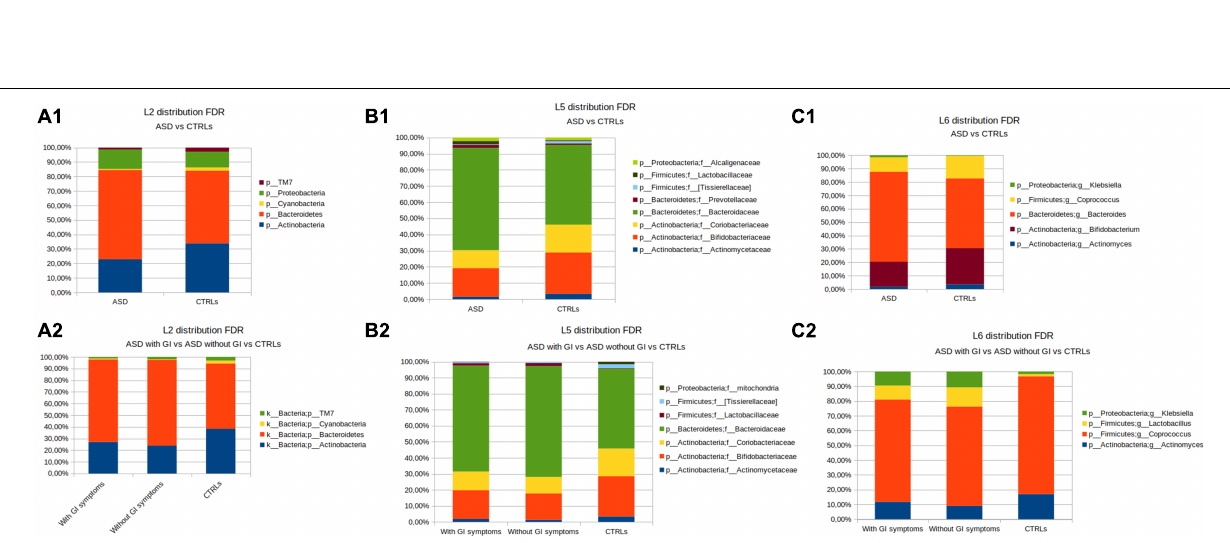
FIGURE 4 | OTUs distribution performed by the Mann–Whitney U-test. (A) The phylum level; (A1) the patients with ASD versus CTRLs; (A2) the patients with ASD grouped for presence of GI (with GI) or GI absence (without GI) symptoms versus CTRLs cohorts. (B) The family level; (B1) the patients with ASD versus CTRLs; (B2) the patients with ASD grouped for presence of GI (with GI) or GI absence (without GI) symptoms versus CTRLs cohorts. (C) The genus level; (C1) ASD versus CTRLs; (C2) the patients with ASD grouped for presence of GI (with GI) or GI absence (without GI) symptoms versus CTRLs. Only statistically significant OTUs (Mann-Whitney U p -value FDR ≤ 0.05) were